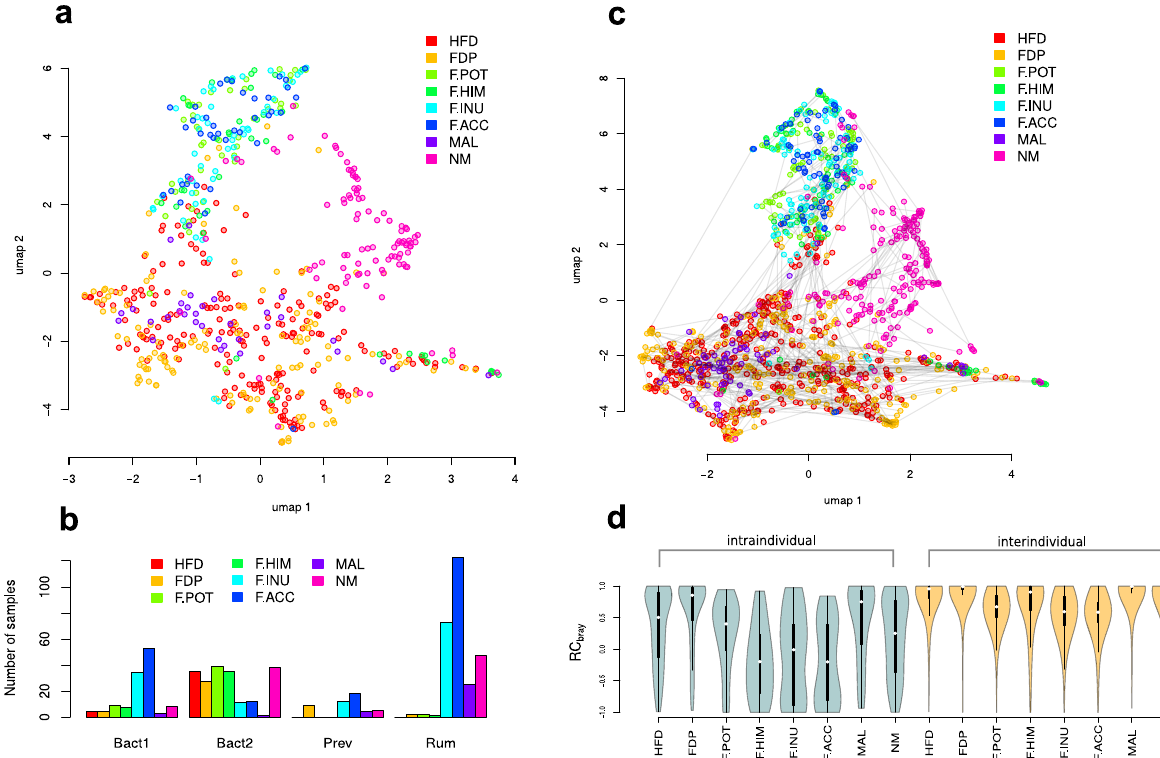
Fig. 2 Variation of microbiome composition in the analysed data. a Distribution of baseline samples in the species abundance space visualised using the UMAP algorithm 65 ( n = 641 samples). Colours denote interventions (abbreviations are disclosed in the text). b Distribution of baseline samples by enterotypes. c Microbiome composition shifts occurring during the interventions visualised in the species abundance space using the UMAP algorithm. Grey lines connect paired samples from the same subject collected before and after the intervention ( n = 1242 samples). d Intra- and interindividual variation calculated using RC bray metric for each of the analysed